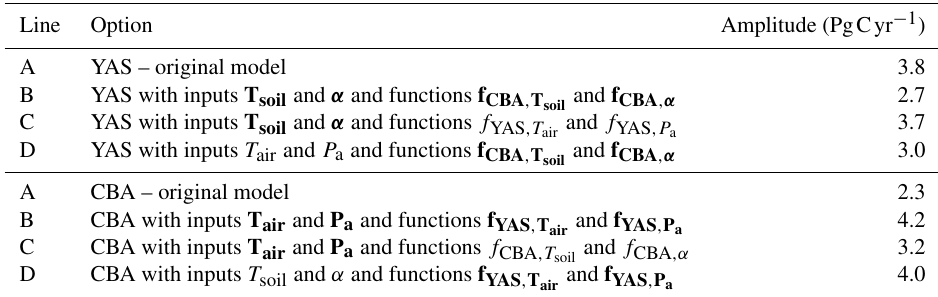
Table A1. The amplitude of global heterotrophic respiration within a year in different box model formulations. The input variables or functions that differ from the original model formulation are in bold